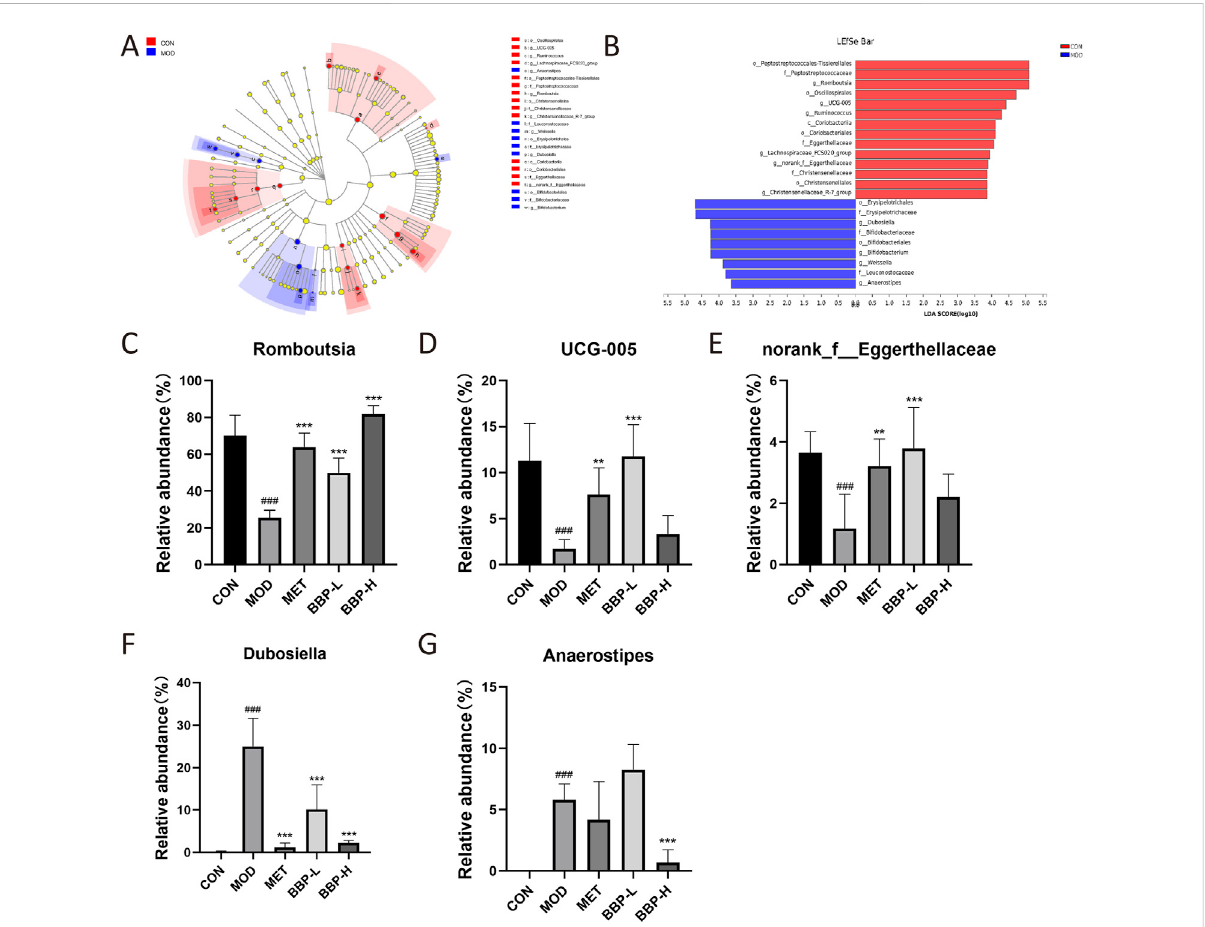
The results of screening differential bacteria and regulating effect of drugs. LEfSe dendrogram (A) , LDA discriminant bar graph (B) . Relative abundance of fi ve fl ora at genus level in each group (C – G). Values are presented as the mean ± SD, n = 6. # p < .05, ## p < .01, ### p < .001: model